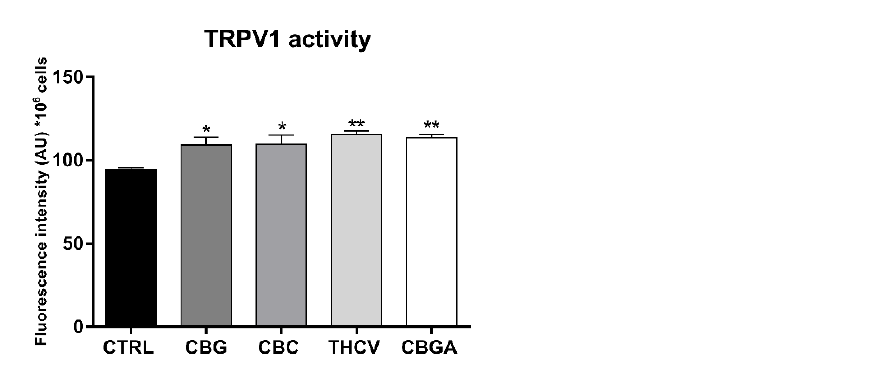
Figure 6. Effects of 24 h of treatment of HaCaT cells with half-IC 50 amounts of CBG, CBC, THCV and CBGA on intracellular Ca 2+ release that was triggered by the selective TRPV1 agonist capsaicin. Data are the means ± SEM of three independent experiments ( n = 3). Statistical analysis was performed using a one-way ANOVA test, followed by the Bonferroni post hoc test (* p < 0.05 and ** p < 0.01 vs. control).